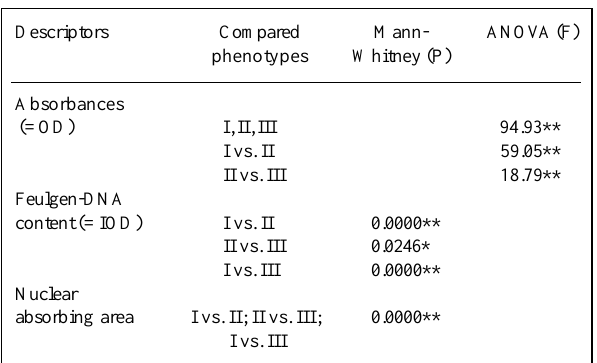
Table II - Comparison of nuclear image analysis parameters in V79 fibroblasts.